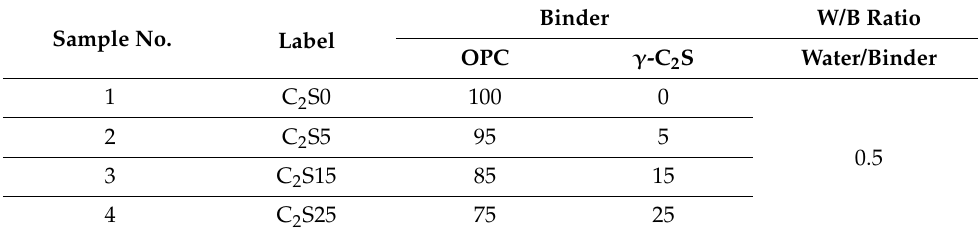
Table 3. Experimental mixing ratios for the cement pastes. Sample No.